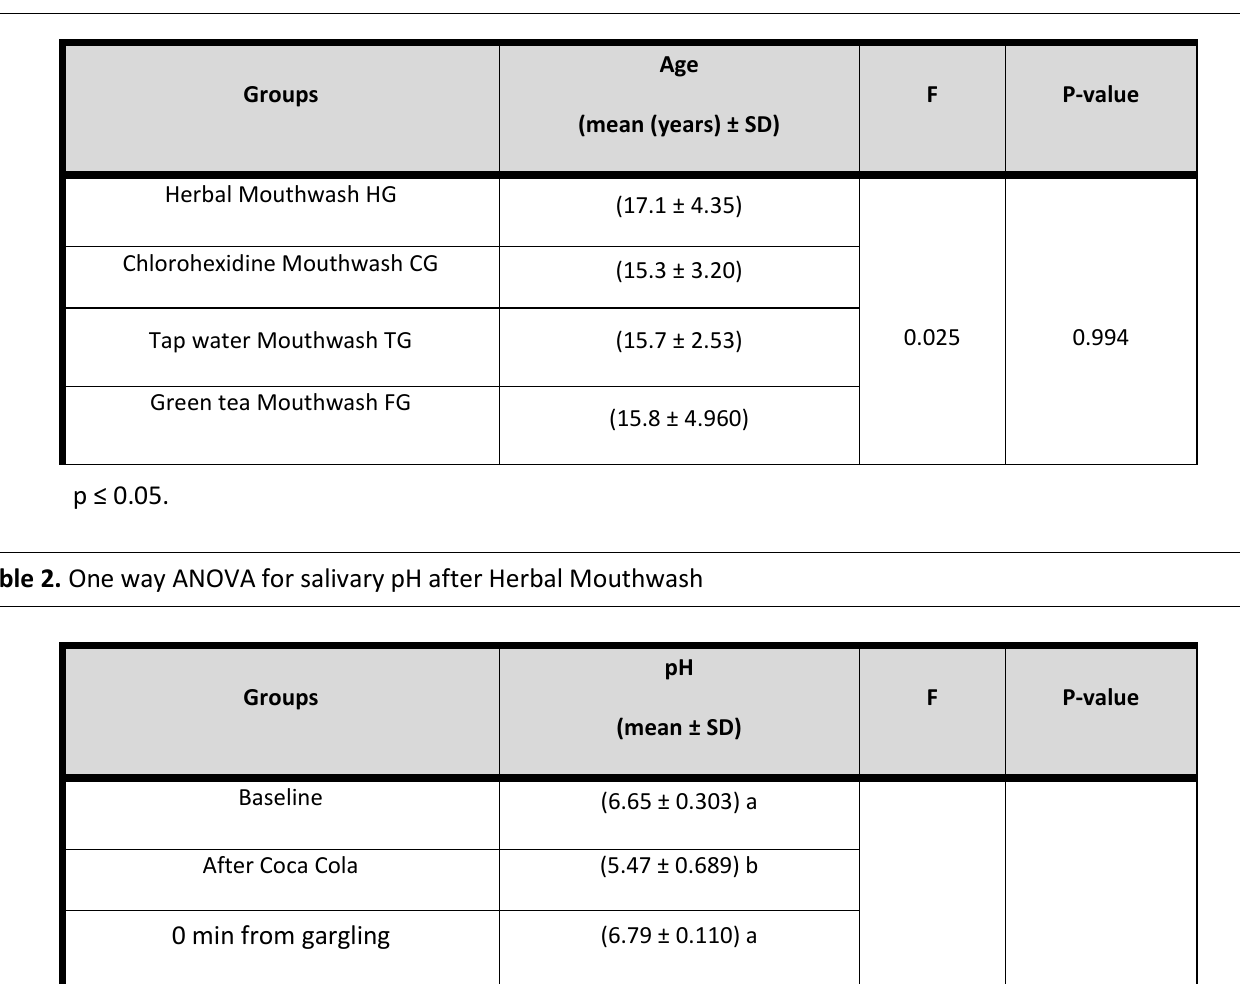
Table 1. The mean age differences between the groups.